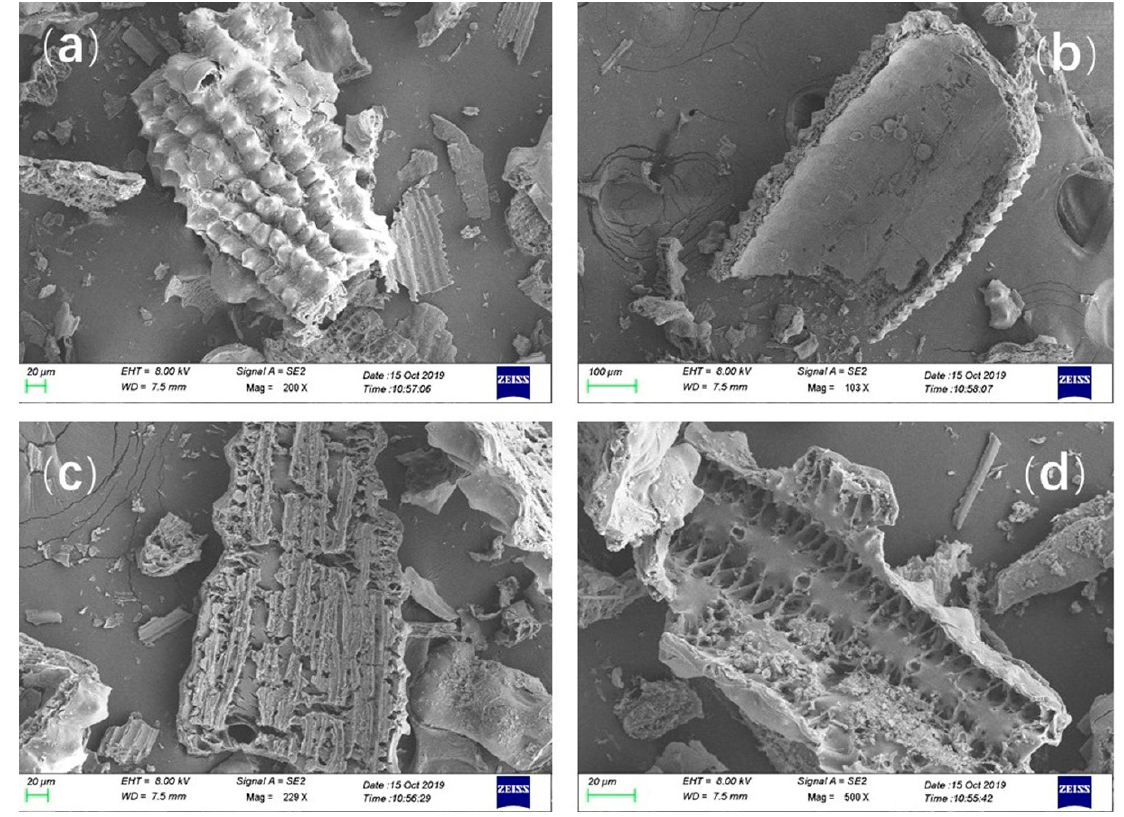
Figure 2. SEM images of RHA: ( a ) outer surface; ( b ) inner surface; ( c ) plane of interlayer; ( d ) cross-section of interlayer.